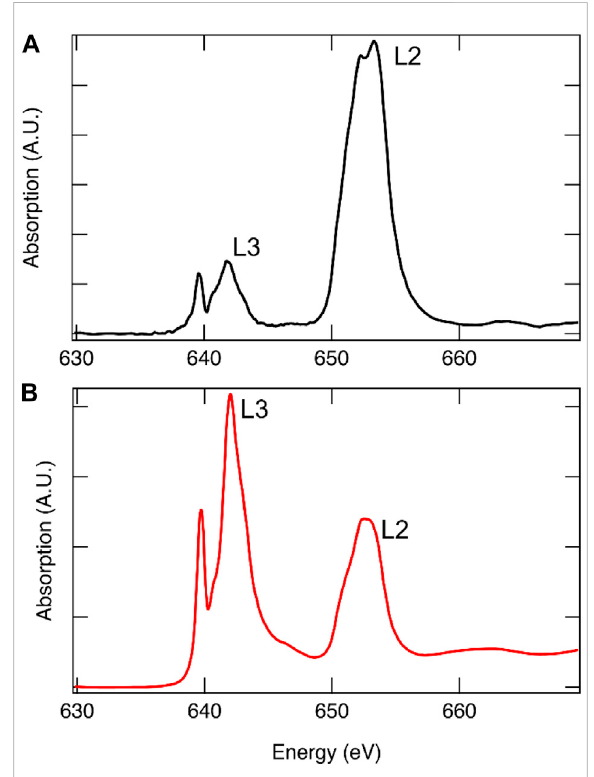
FIGURE 8 Mn L-edge of 12 R -Ba 4 Ce 1 Mn 3 O 12 collected using FY[ (A) , black] and TEY [ (B) , red]. Due to spin – orbit coupling, the L-edge is comprised of two edges, with the lower energy edge arising from J = (1 + s) = 3/2 transitions termed L 3 and the higher energy fromJ=(1 − s)=1/2transitionstermedL 2 .Fromdegeneracyofthe states, it is expected that the L3:L2 intensity ratio is approximately 2:1. Self-absorption is readily apparent in the FY spectrum where the relative intensities are not